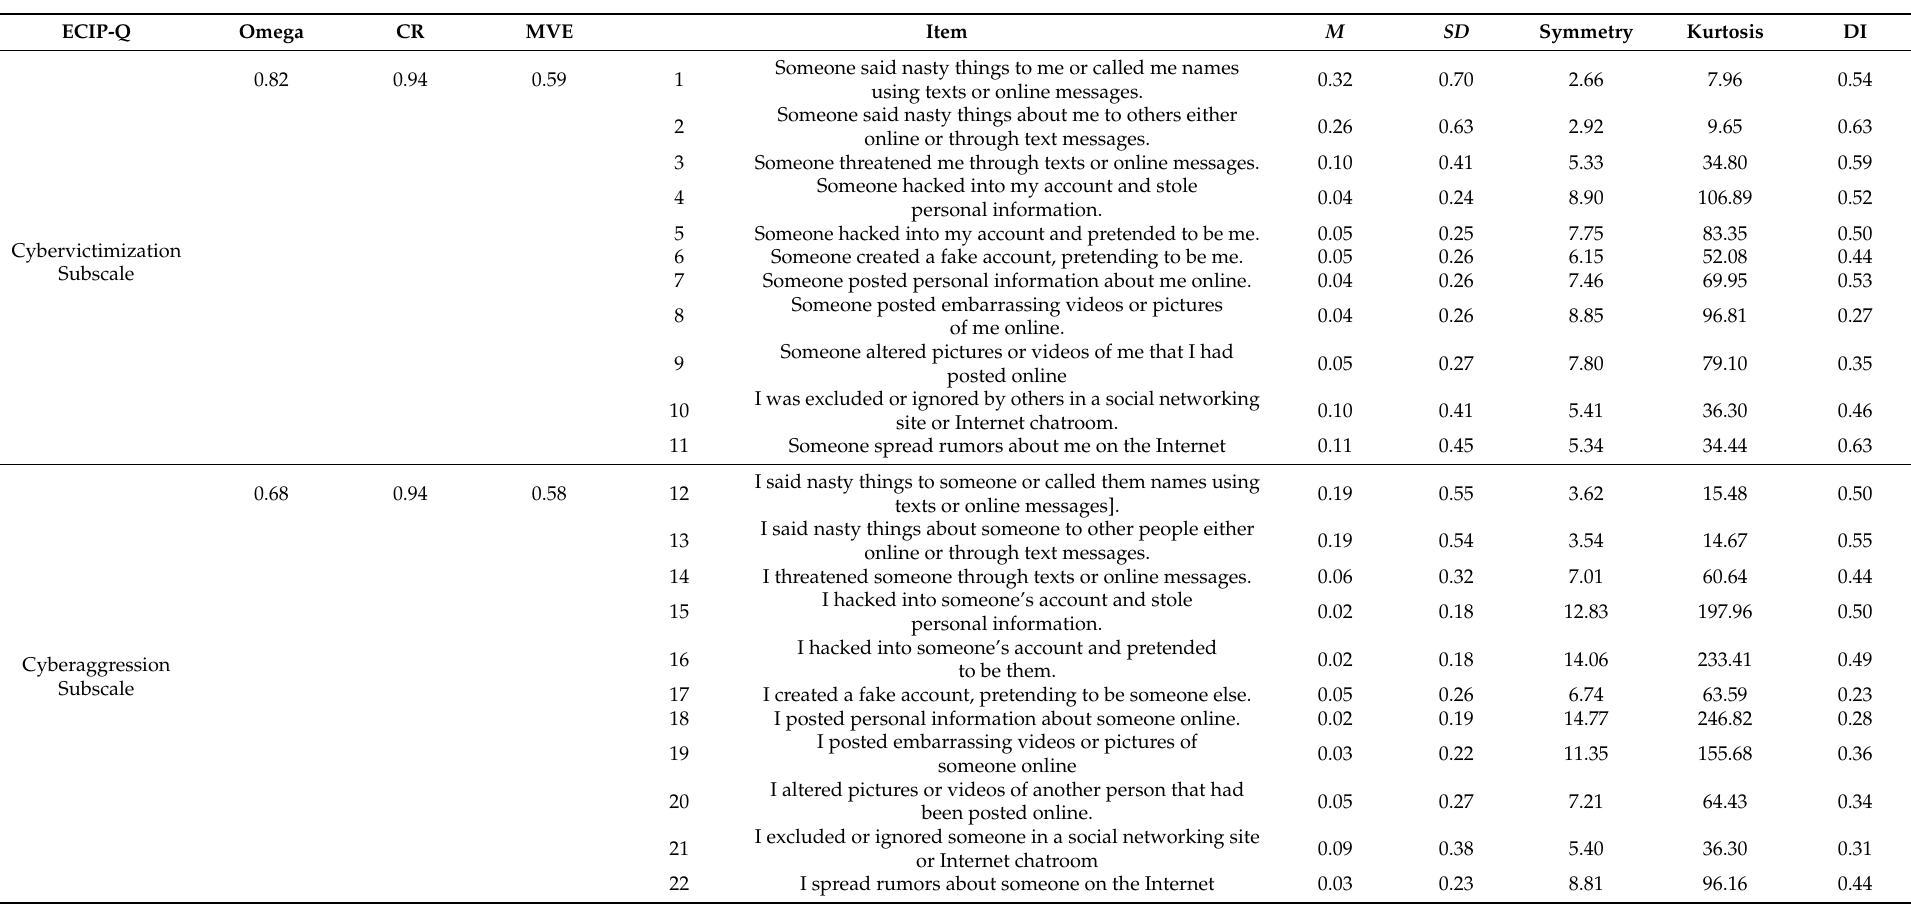
Table 1. Reliability of the subscale scores of the European Cyberbullying Intervention Project Questionnaire and descriptive statistics of the items. ECIP-Q Omega CR MVE Item